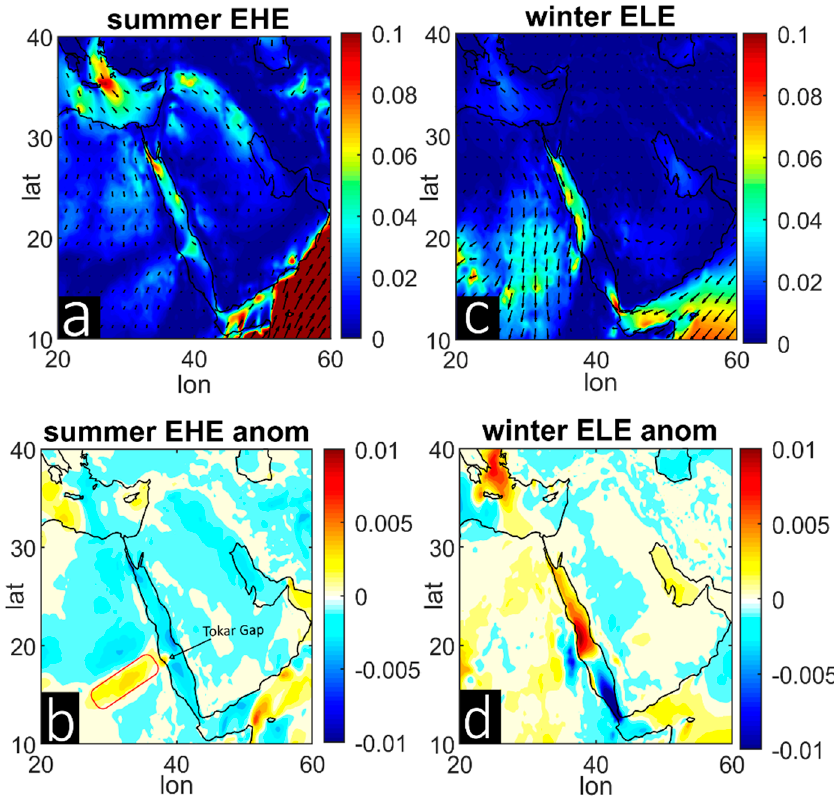
Figure 5. Composite wind stress ( a ) and associated anomaly values ( b ) in Pa for EHEs. Same for ( c ) and ( d ) but for ELEs. The shaded color represents the magnitude of the wind stress, while the black arrows in ( a ) and ( c ) represents the direction.